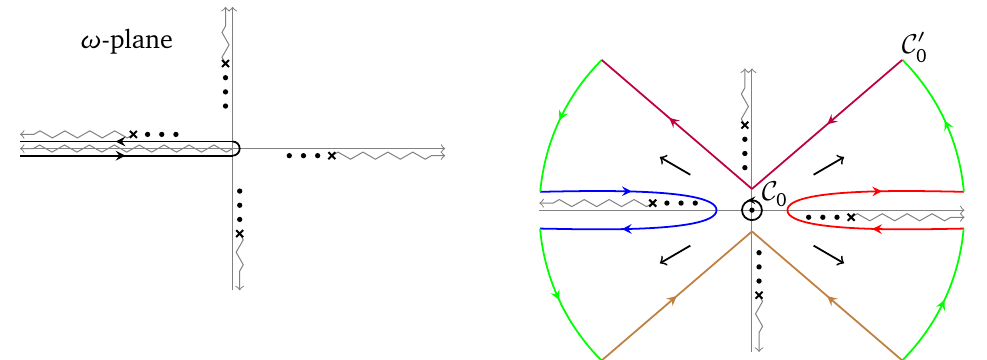
. Right: Pulling the contour C ,0 ] , the blue contour D 0 , and finally the green 3